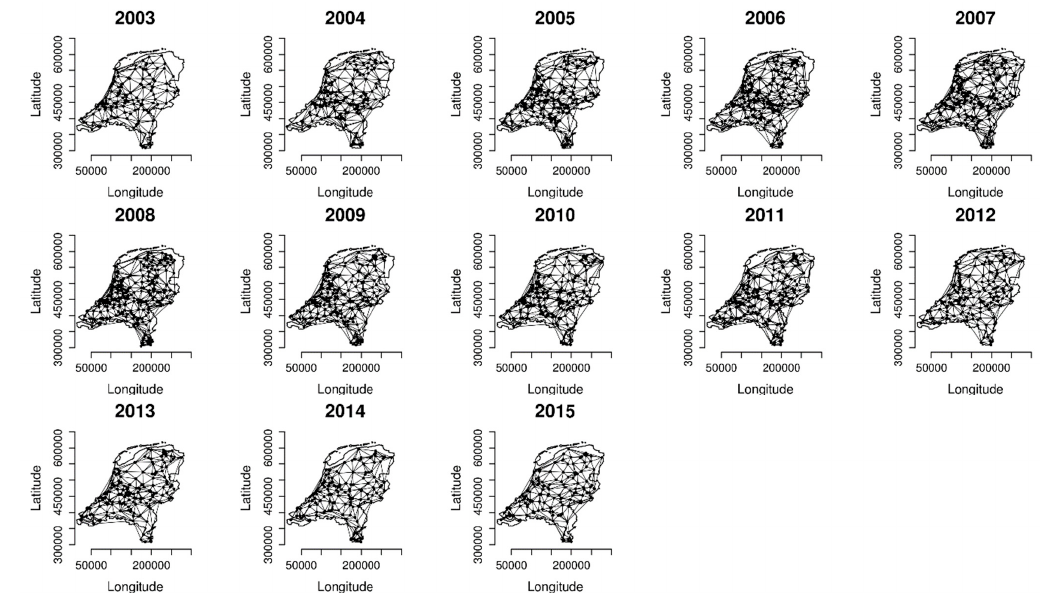
Figure 2. Annual graphs for lesser celandine flowering onset observations. The graphs were made using a Delaunay triangulation and edges longer than 100 km were pruned. ISPRS Int. J. Geo-Inf. 2018 , 7 , x FOR PEER REVIEW